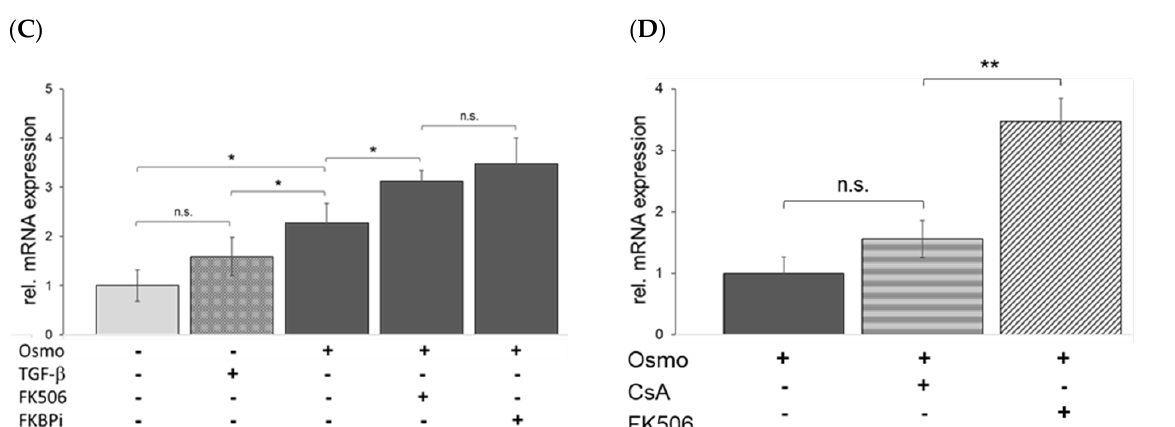
Figure 8. FK506 modulates TGF- β signaling in chondrocytic cells. ( A ) Effects of FK506 and TGF- β RI inhibitor (LY210961) on SMAD3 expression. ( B ) Physosmotic TGFBI induction and modulation by TGF- β 1, FK506, or FKBPi. ( C ) Physosmotic regulation of Id1 expression and effects of TGF- β , FK506 and FKBPi (n = 5) . ( D ) Effects of FKBP-independent and -dependent calcineurin inhibitors cyclosporin A (CsA, 1 μ M) and FK506 (620 nM), respectively, on aggrecan expression (n = 3); osmo + = +100 mOsm/kg; LY210961 +, 0.1 μ M; ++, 1 μ M; isosmotic *, p < 0.5; **, p <0.01; #, ## 380 vs. 280; n.s., not significant.